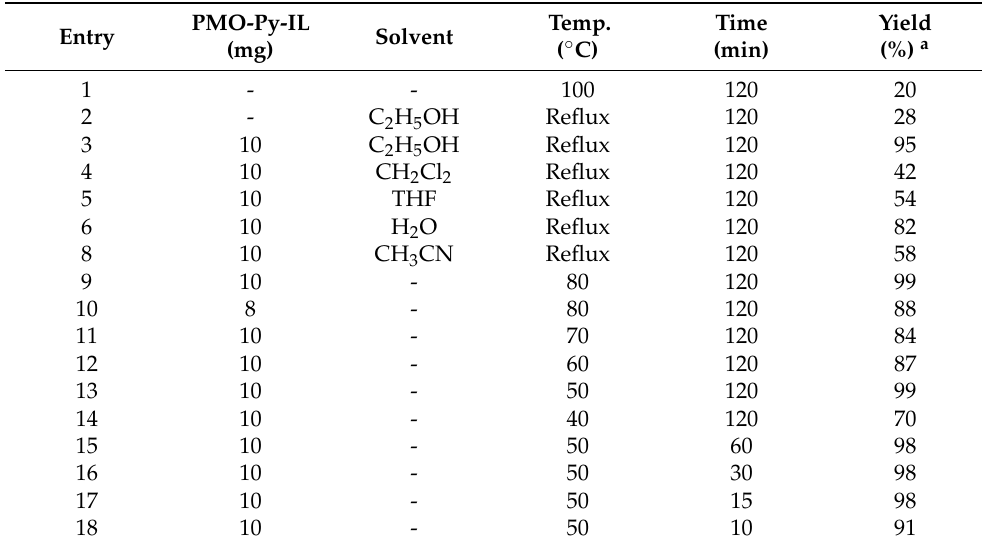
Table 1. Effect of different parameters on the Biginelli reaction of ethyl acetoacetate (10 mmol), benzaldehyde (10 mmol), and urea (12